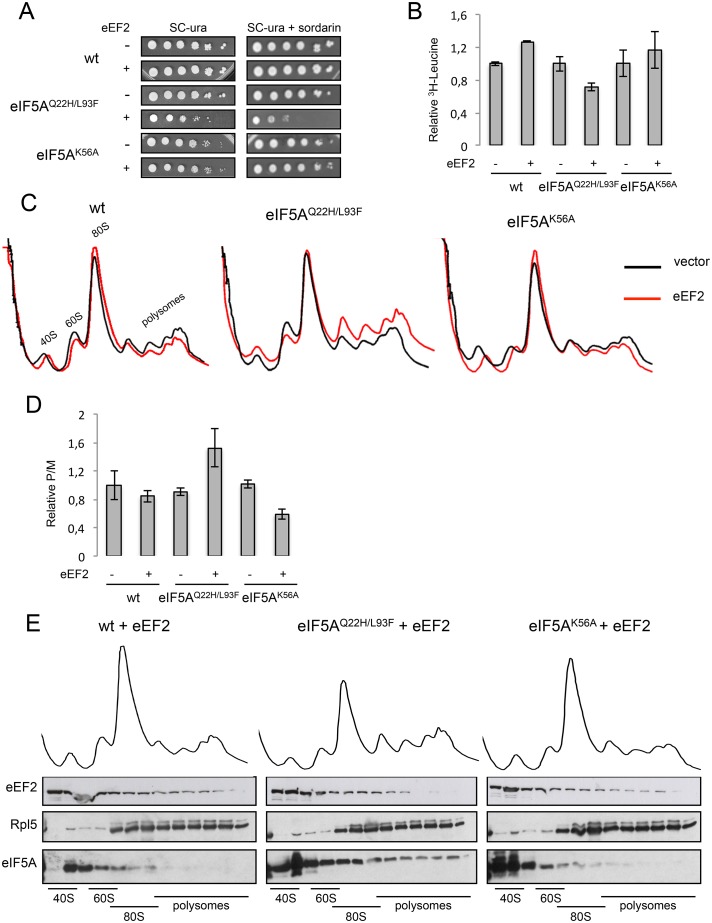
Analysis of the effect of eEF2 overexpression on the phenotypic defects of the mutants eIF5AK56A and eIF5AQ22H/L93F at the permissive temperature (25°C).(A) Ten-fold serial dilutions of wt, eIF5AQ22H/L93F or eIF5AK56A, containing empty vector or high-copy eEF2, were grown in SC-ura at 25°C in the presence or not of sordarin (200 ng/mL). (B) Total protein synthesis was measured in the same cells by the incorporation of [3H]leucine, relative to the wt strain. (C) and (D) Polysome profile analysis of the same cells was carried out and the quantification of polysome and monosome areas (P/M) were performed to show the levels of translation. (E) Polysome profile fractions of eIF5AQ22H/L93F and eIF5AK56A in the presence of high-copy eEF2 were analyzed by western blot to detect the presence of eIF5A, eEF2 and Rpl5. The error bars in B and D represent the standard deviation of the experimental values for three independent replicates and the data are expressed as mean values ±SD.